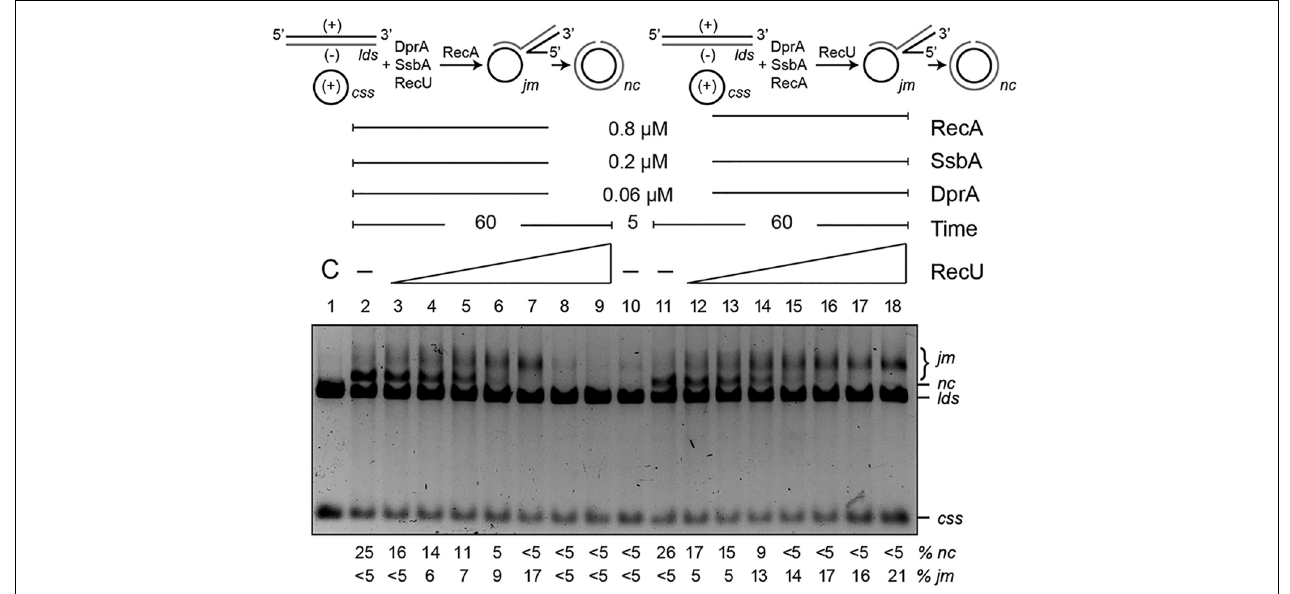
FIGURE 8 | DprA antagonizes the inhibitory effect of RecU on DNA strand exchange. Top left, scheme of reactions performed on the left part of the gel (lanes 2–9). The css (+ strand in black) and the homologous lds (– in gray) substrates were preincubated with SsbA, DprA, RecU, and ATP (5 min, 37 ◦ C), after which RecA was added. Top right, scheme of the reactions performed on the right part of the gel (lanes 11–18). Here, DNA substrates were preincubated with SsbA, DprA, RecA, and ATP (5 min, 37 ◦ C), followed by RecU. The predicted intermediates ( jm ) and final products ( nc ) are illustrated. Homologous ssDNA (10 µ M) and dsDNA (20 µ M) were preincubated with SsbA, DprA and with variable concentrations of RecU (lanes 3–9; doubling from 6.2 to 400 nM) or a fixed RecA concentration (lanes 11–18) in buffer B containing 5 mM ATP (5 min, 37 ◦ C). A fixed RecA concentration (lanes 2–9) or variable amounts of RecU (lanes 12–18) were then added and the reaction was incubated (60 min, 37 ◦ C). Lane 1, DNA substrate controls (C); lanes 2 and 11, RecU was omitted, and in lane 10, the reaction was terminated after preincubation (5 min) without RecU. Reactions were resolved after deproteinization by 0.8% agarose gel electrophoresis. Band positions for css , lds , cds , jm, and nc are indicated. Bottom, recombination intermediates ( jm ) and products ( nc ) are expressed as the percentage in respect to the total substrate added. Results are shown as the mean ± 5% SEM of ≥ 3 independent